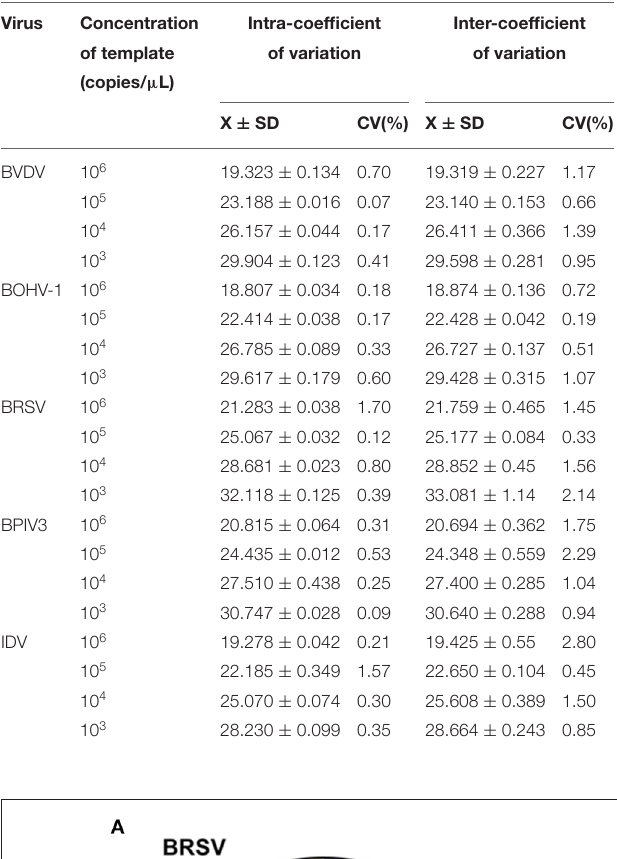
TABLE 3 | Repeatability of the multiplex real-time PCR assay.